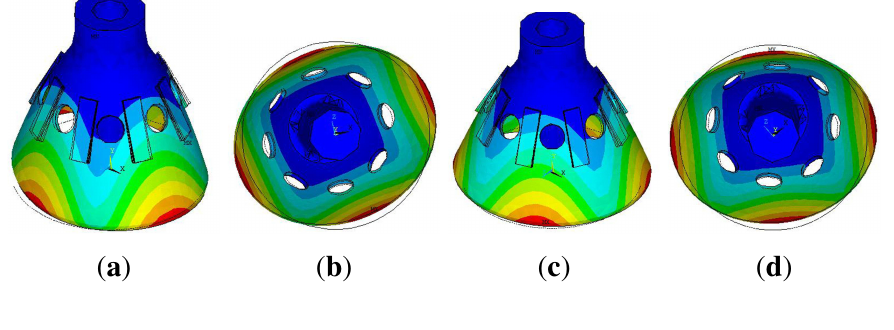
Figure 10. Schematic of the work mode shape. ( a ) Front View of Primary Mode. ( b ) Bottom View of Primary Mode. ( c ) Front View of Second Mode. ( d ) Bottom View of Second